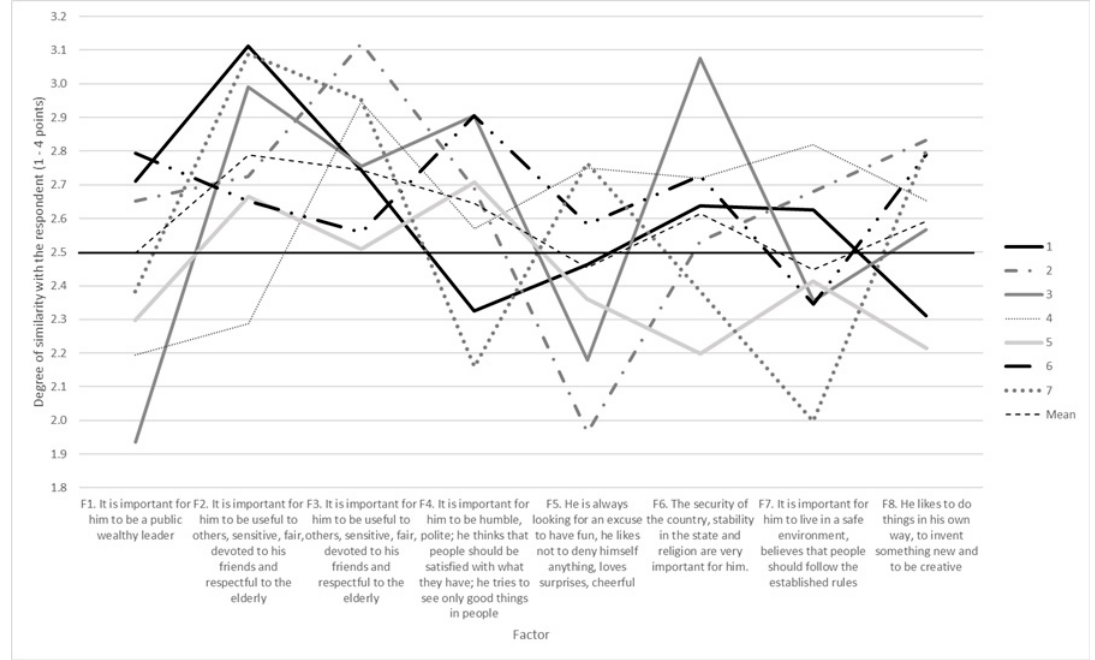
Table 6. Dimensions and shares of respondent’s (car owners) clusters.